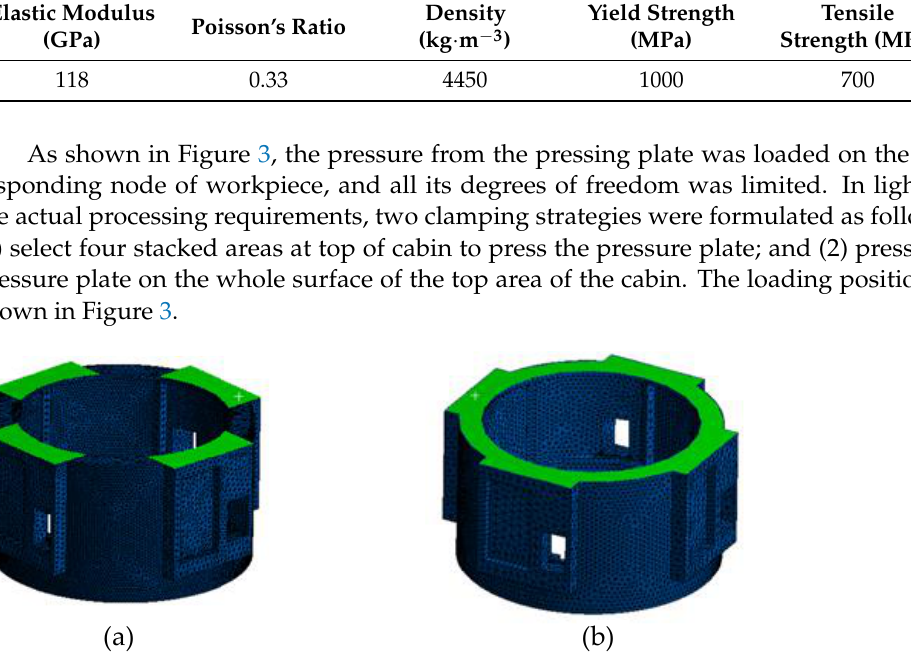
Figure 3. Loading position of different clamping strategies. ( a ) Loading position of clamping strategy 1; ( b ) loading position of clamping strategy 2.